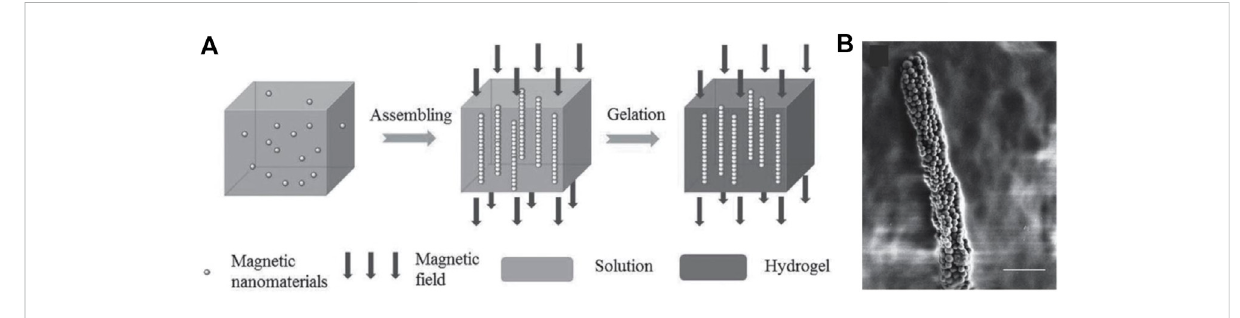
FIGURE 3 Morphology of the fabricated chain-like assemblies inside hydrogel. (A) Schematic diagram of the fabrication process for aligned magnetic hydrogel. (B) SEM of magnetic hydrogel with chains. Scale bar = 1 µm. (Reproduced with permission from (Hu et al., 2015a) Copyright 2015